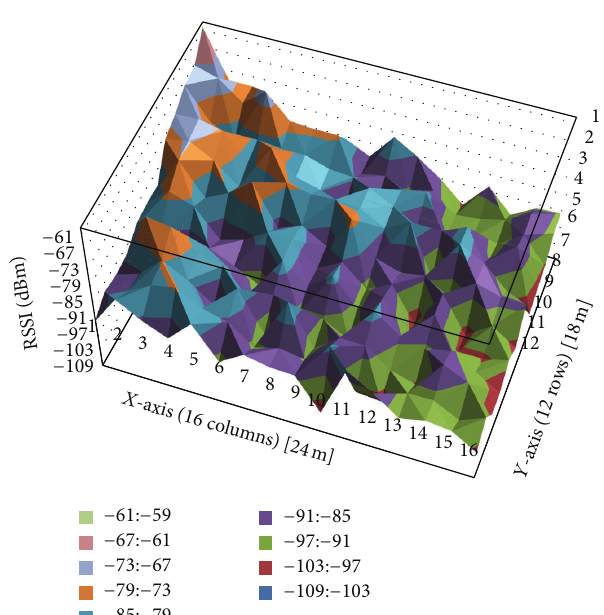
Figure 2: Distribution of RSSI values in the test